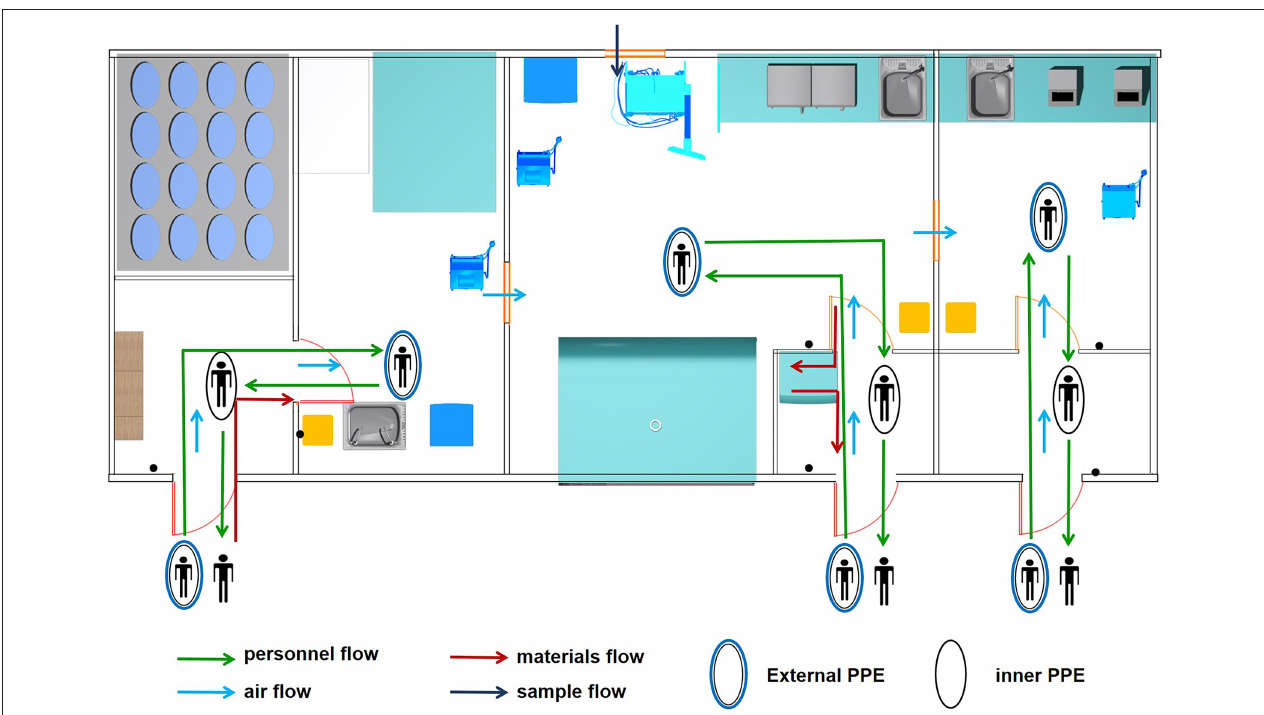
FIGURE 2 | Four flows involved in biosafety risk. Personnel, air, sample and material flows were the main components of biosafety risk in the mobile biosafety laboratory.